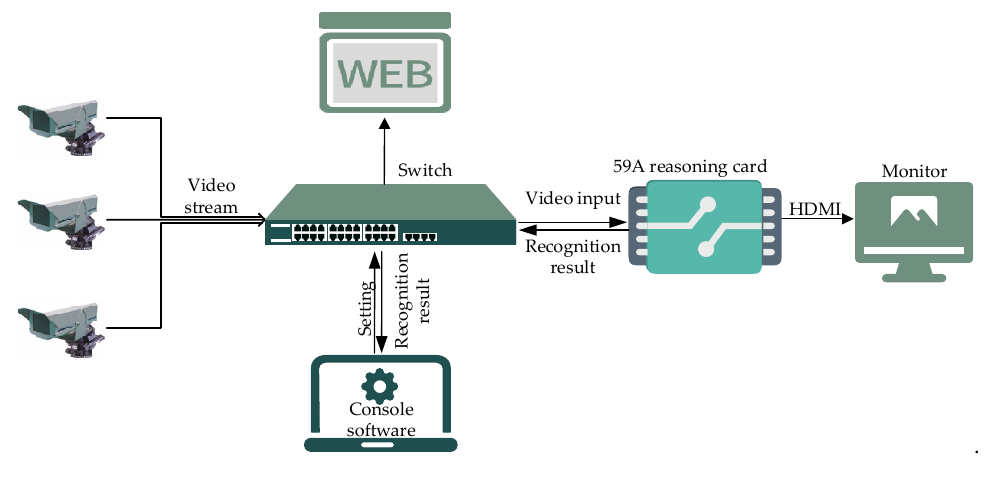
Figure 1. System scheme.